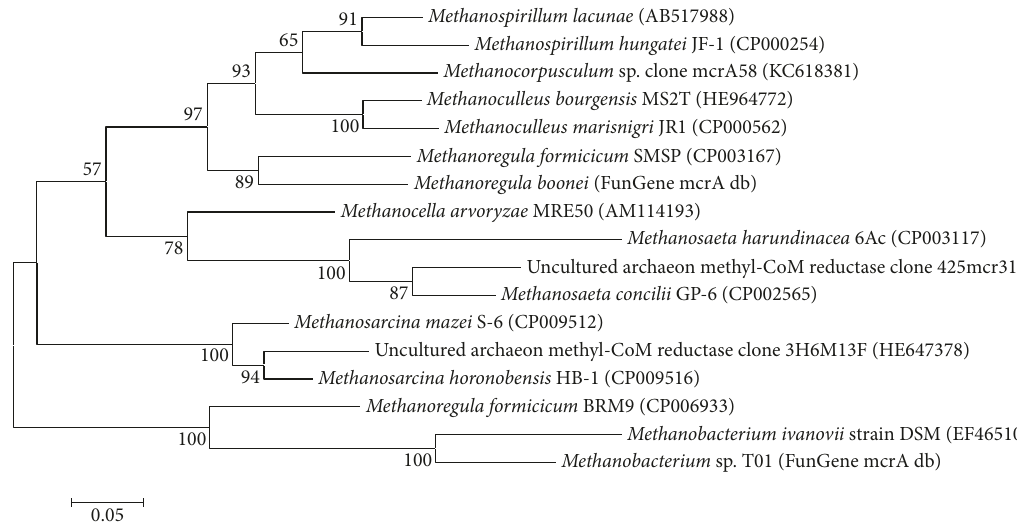
Figure 5: Phylogenetic tree of all identified methanogenic species in the amplified mcrA gene samples.